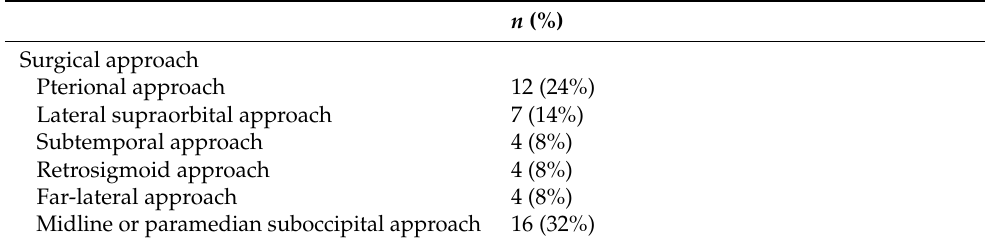
Table 3. Surgical techniques, outcomes, and